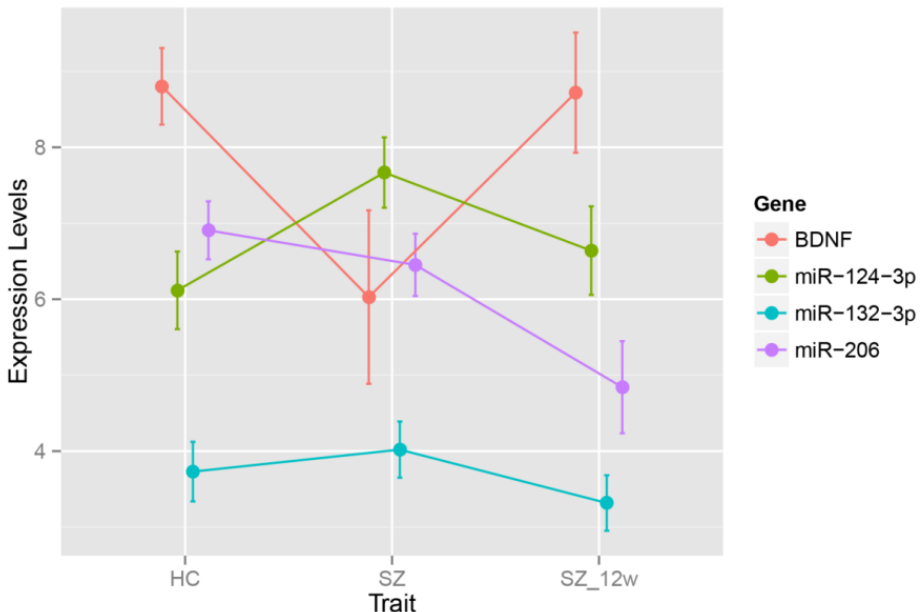
Figure 1. Expression levels in healthy controls and SZ patients before and after antipsychotic treatment. HC—healthy control; SZ—schizophrenia.